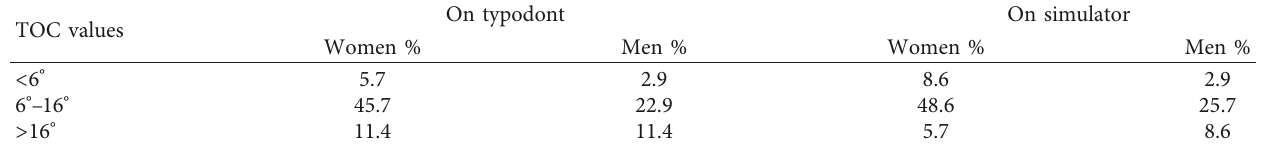
Table 2: Distribution of students according to TOC values on typodont and simulator by sex. On typodont TOC values